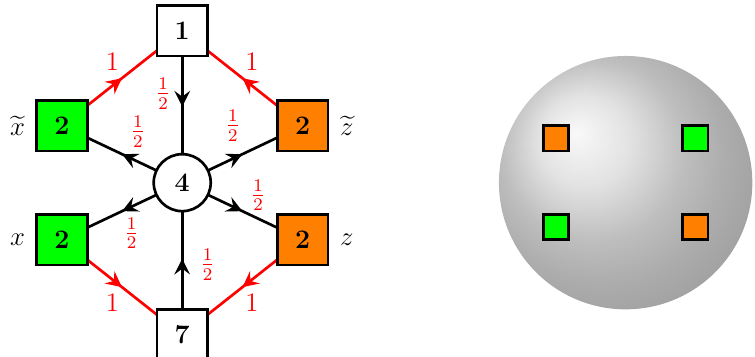
Figure 6: The A four-punctured sphere theory with zero flux: SU ( 4 ) SQCD with 1 = 8. Fugacities of all of the fields can be identified from the index specified in N f (B.4) upon putting N = 1. Red lines correspond to the flips of mesonic operators of this theory. This theory has superpotentials turned on corresponding to the triangles in the quiver and baryonic superpotentials preserving the puncture symmetries (and including quarks charged under orange and green SU ( 2 ) symmetries). Here, and everywhere in the paper, we do not discuss the subtle issues of the relevance of the superpotentials as this does not play a role in the derivation of the A ∆